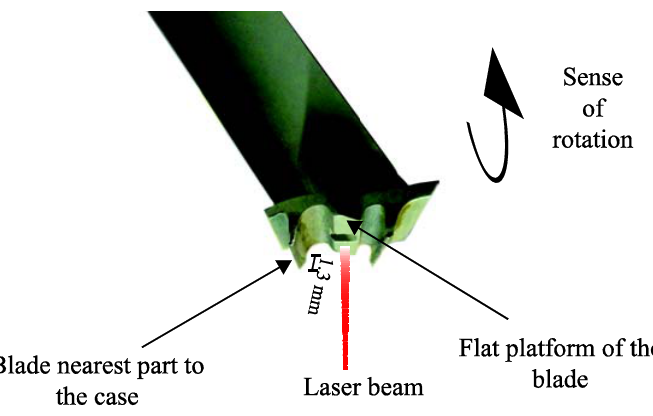
Figure 4. Blade profile